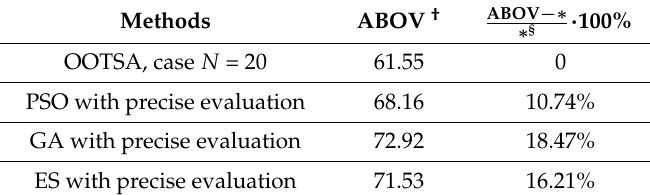
Figure 7. Comparison of the computing efficiency and solution quality of four methods over 30 independent runs. Table 3. Statistics of the average best-so-far objective values at termination over 30 independent runs.